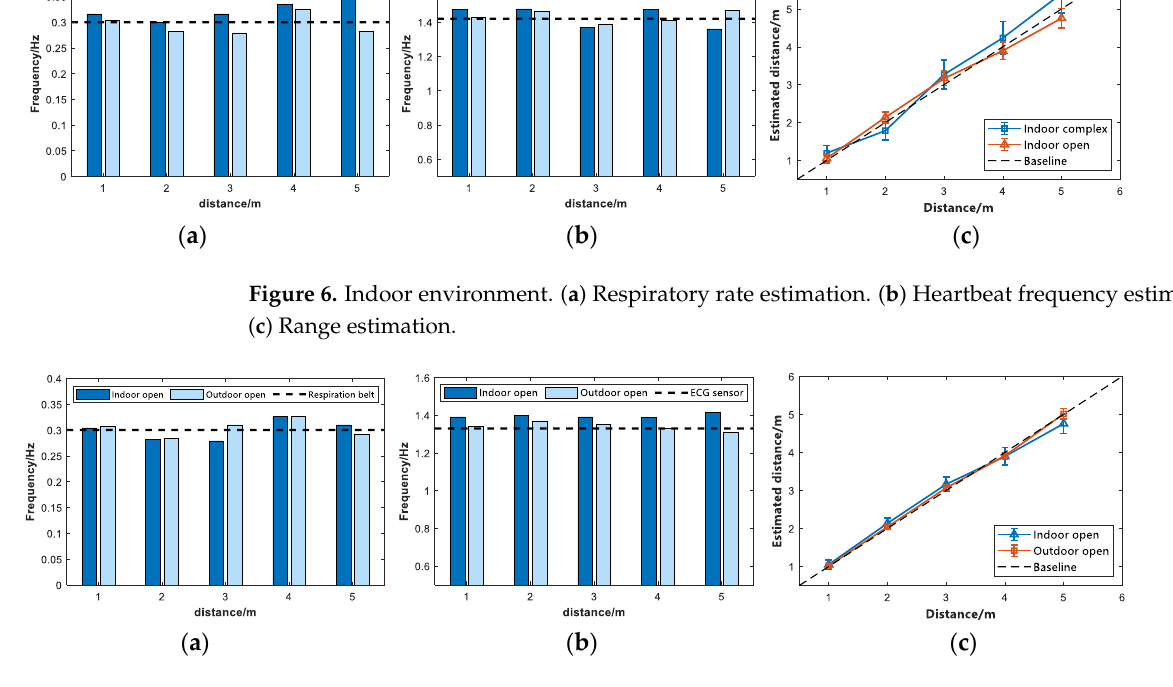
Figure 7. Open environment. ( a ) Respiratory rate estimation. ( b ) Heartbeat frequency estimation. ( c ) Range